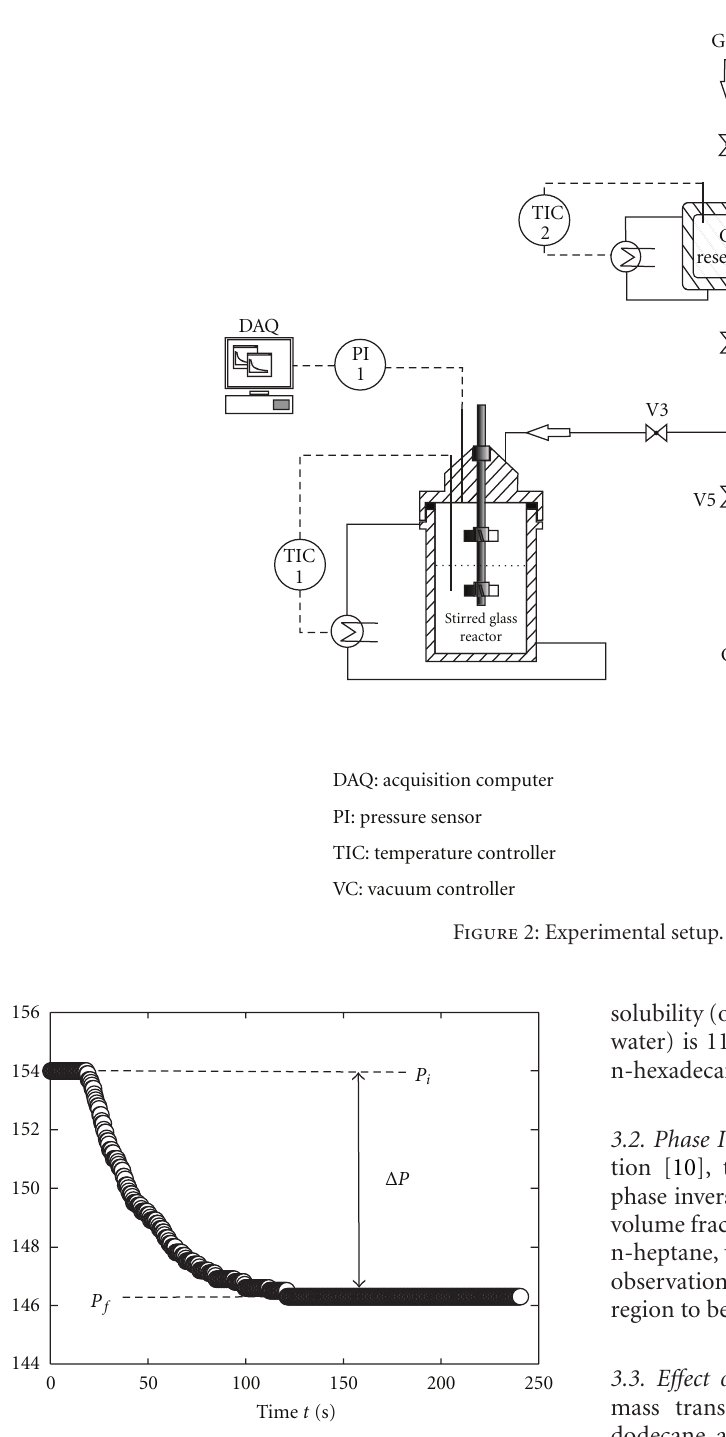
Figure 3: Pressure decrease during O 2 absorption into n-dodecane emulsion ( Φ oil =